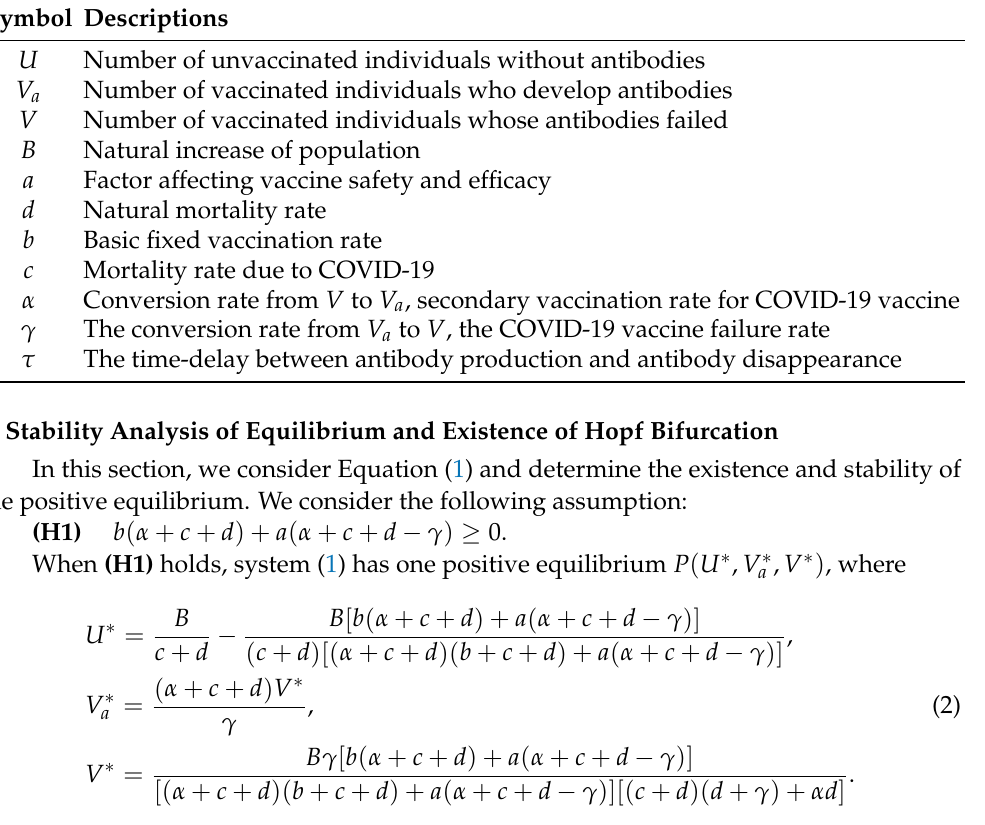
Table 1. Descriptions of variables and parameters in the model